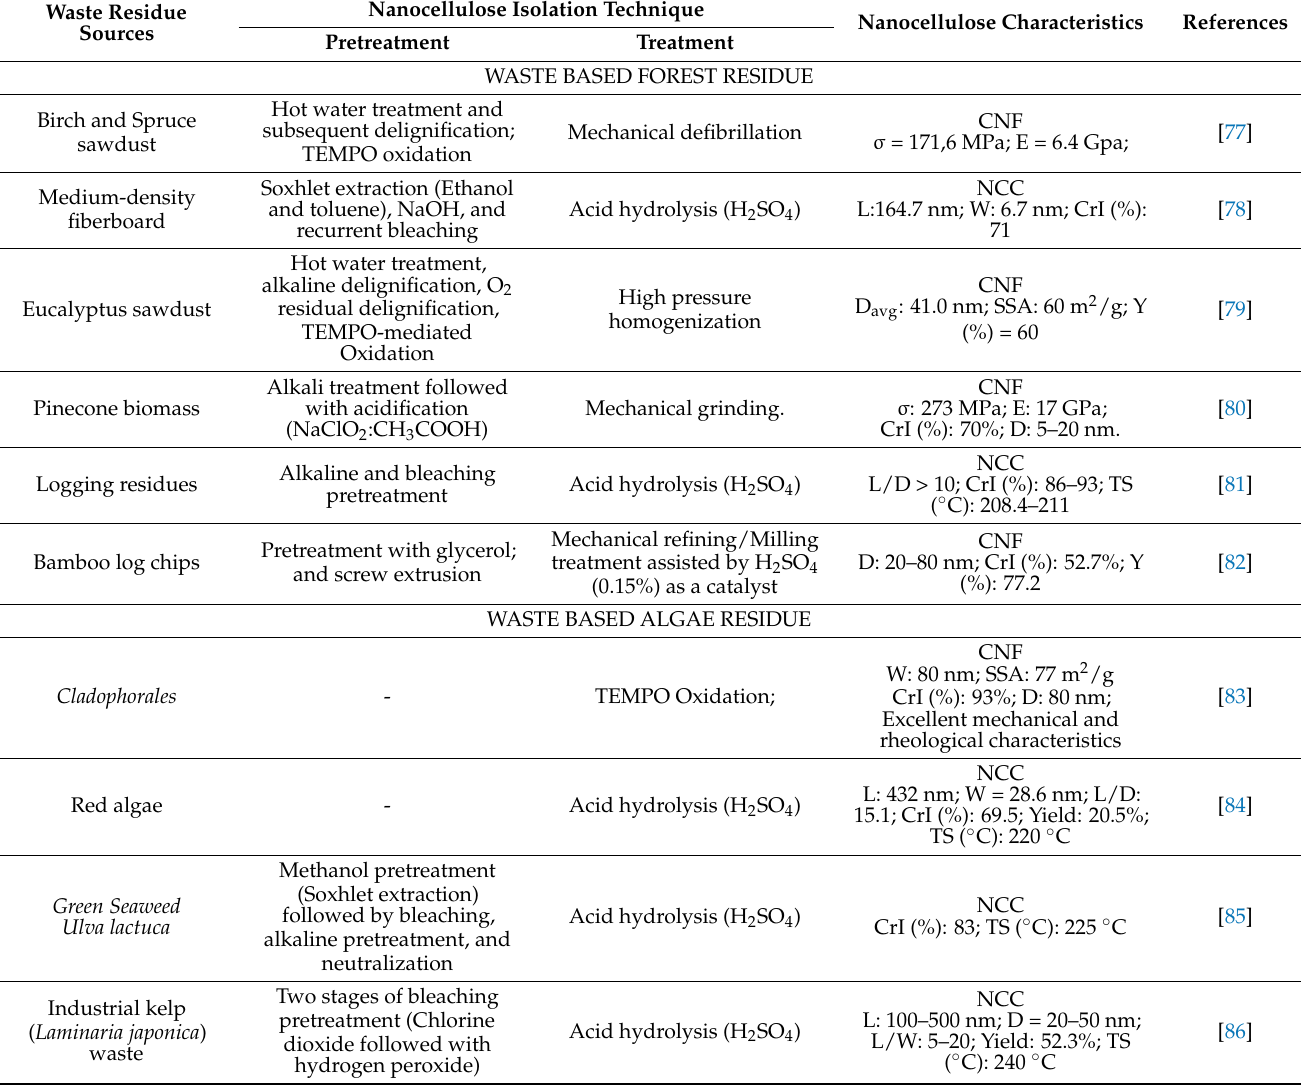
Table 2. Summary of waste-based sources for nanocellulose production and its